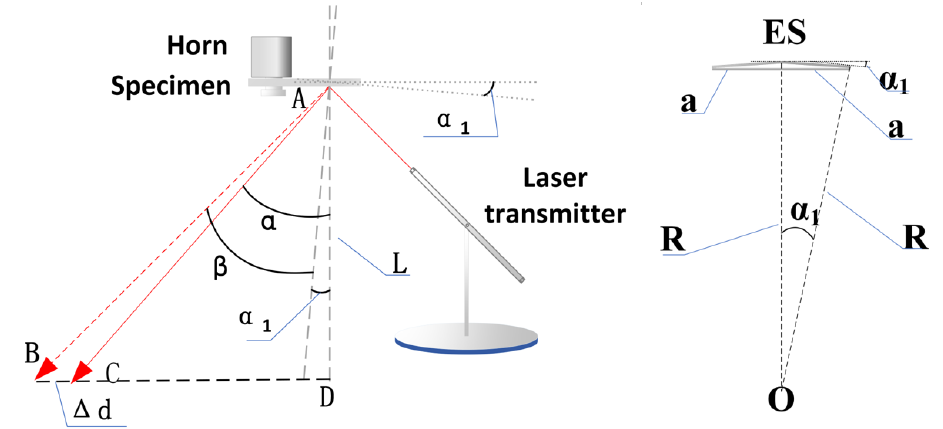
Figure 4. Schematic diagram of laser curvature measurement.